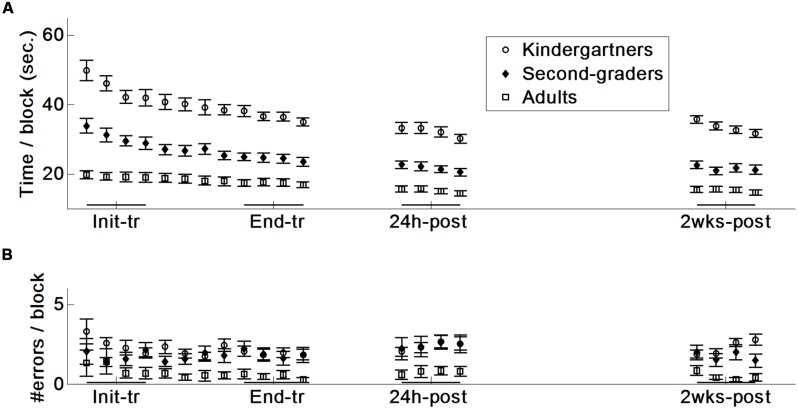
Speed and accuracy data (mean and standard error): initial training (Init-tr, blocks 1–4 on day 1), end-training (End-tr, blocks 9–12 on day 1), 24 h post-training (24 h-post), and 2 weeks post-training (2 wks-post). (A) Time per block. (B) Number of erroneous patterns produced.